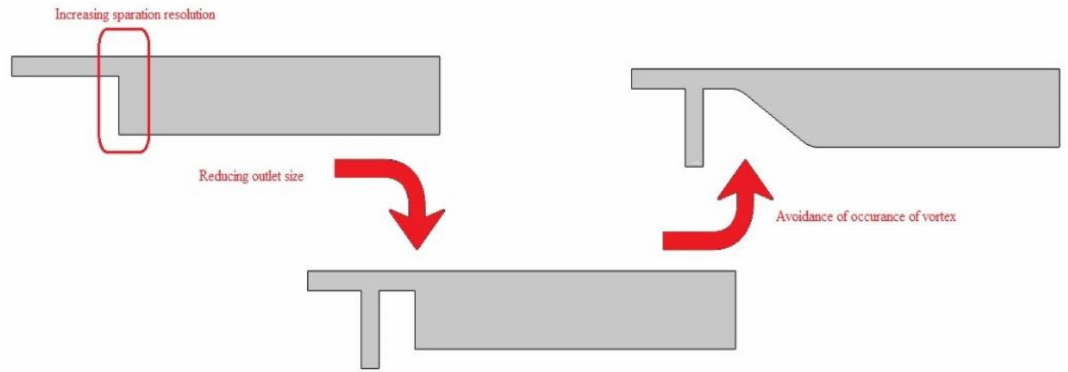
Figure 4. The evolution process of primary geometry: first by introducing an ancillary flow pf particles, dispersion is reduced and then, by gradual increase of cross-section, the induced vortices are